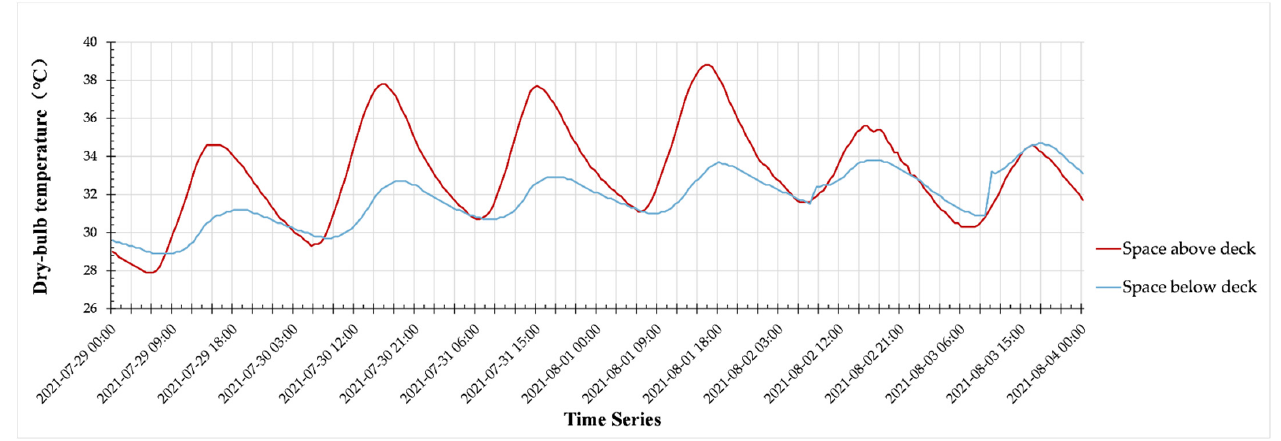
Figure 7. Temperatures in the ship between 29 July and 4 August 2021.